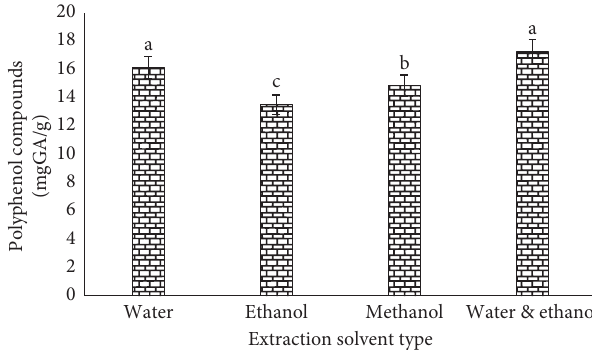
Figure 2: Comparison of mean phenolic compounds of extracts obtained from different solvents in the maceration